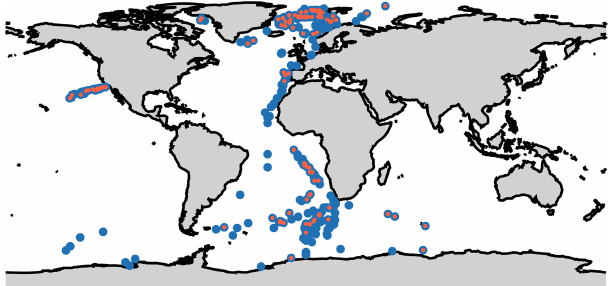
Figure 2. Map showing the geolocations of the radiosondes used in this study. Blue dots display the radiosondes that fulfill the criteria used in Fig. 3a while red dots display the subset that fulfills the criteria of Fig.